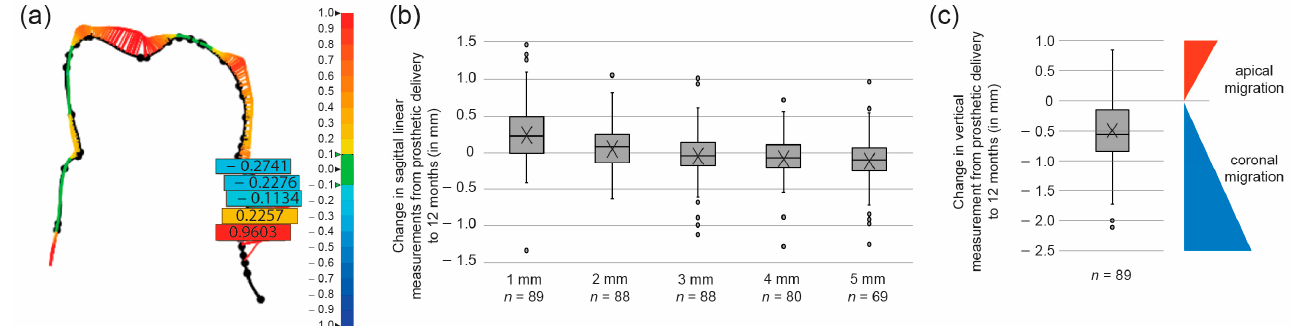
Figure 4. Soft tissue stability from prosthetic delivery to 12-month follow-up based on IOS profile analysis. ( a ) Example of a two-dimensional comparison of the digital profiles collected at the final prosthesis delivery and 12 months thereafter, with the five locations on the vestibular side chosen for linear measurements, from 1 to 5 mm in apical direction from the mucosal margin. Changes in volume are color coded, where green represents perfect alignment, the color range from yellow to red represents increasing size, and the color range from light to dark blue signifies size decrease (see scale on the right side of the panel). ( b ) Box and whisker plot illustrating the changes in the linear measurements at the five sagittal locations. Crosses indicate means and circles outliers. The number for sagittal measurements at 4 and 5 mm is lower because the scanner could not evaluate all the scan images in the most apical sagittal region. ( c ) Box and whisker plot illustrating the changes in the vertical measurement. Crosses indicate means and circles outliers. Note that the negative value reflects a coronal migration of the mucosal margin, i.e., a positive clinical outcome.